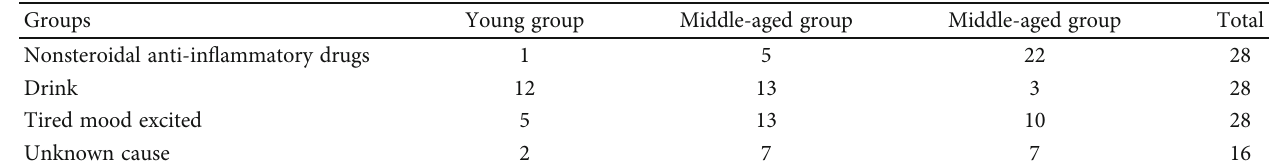
Table 3: The composition of triggers in di ff erent age groups.